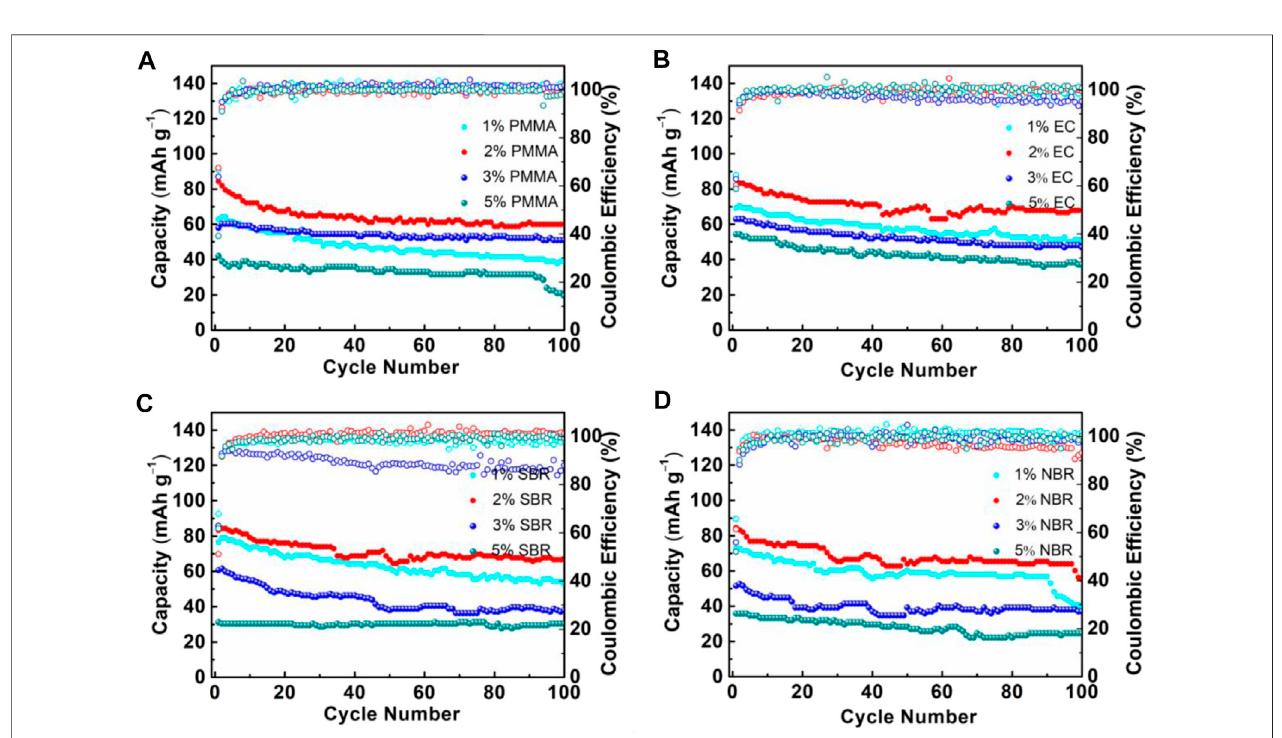
FIGURE 4 | Cycling performance at 0.05C of cathode composites with different amount of binder (A) PMMA, (B) EC, (C) SBR, and (D) NBR.